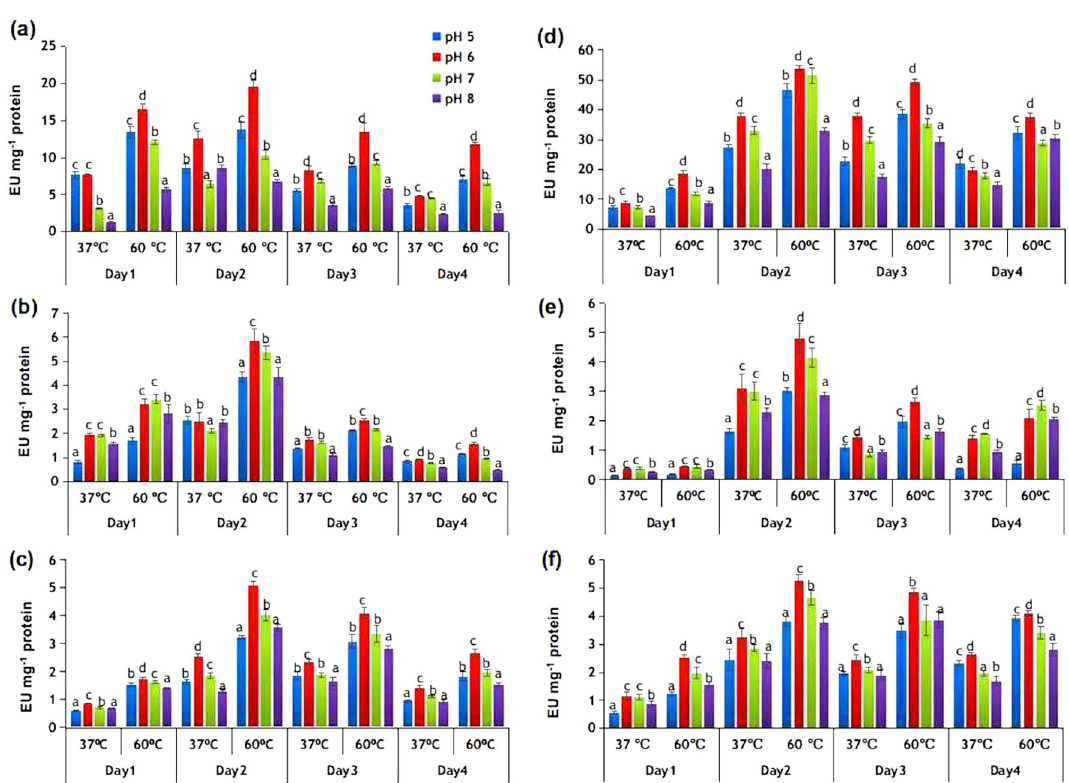
Figure 2. Glycoside hydrolase activities in cell free supernatant of RSV consortium: effect of temperature and pH on activities of ( a ) endoglucanase, ( b ) cellobiohydrolase, ( c ) β-glucosidase, ( d ) endoxylanase, ( e ) β-xylosidase, and ( f ) arabinofuranosidase, during four days of growth of RSV. Data marked with different letters are significantly different (p < 0.05) as suggested by one-way ANOVA followed by DUNCAN multiple range